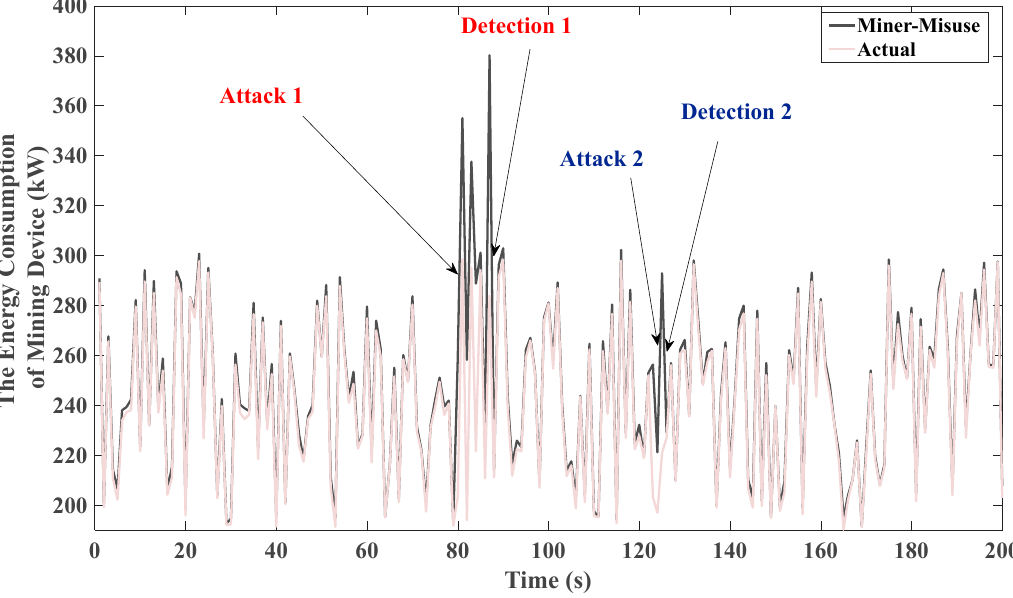
Figure 6. Illustration of the energy consumption under miner misuses.